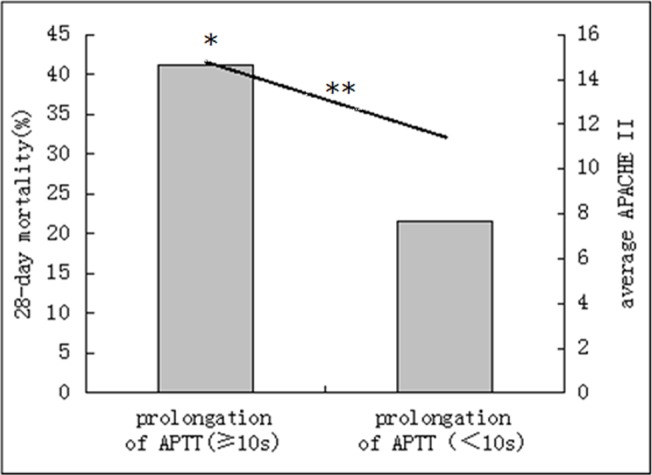
Acute Physiology and Chronic Health Evaluation II (APACHE II) score and 28-day mortality by prolongation of activated partial thromboplastin time (APTT).Bar graph shows 28-day mortality (*p = 0.000). Line graph shows the average APACHE II score (**p = 0.000).